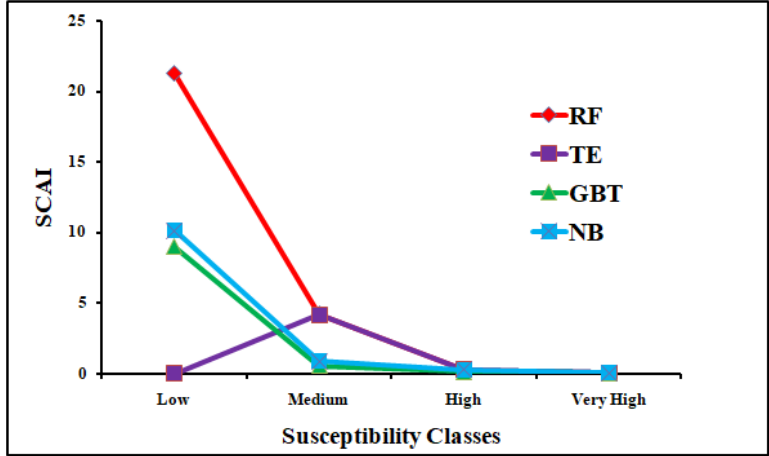
Figure 10. Seed cell area index (SCAI) values for different susceptibility classes in RF, NBT, GBRT, and TE models.